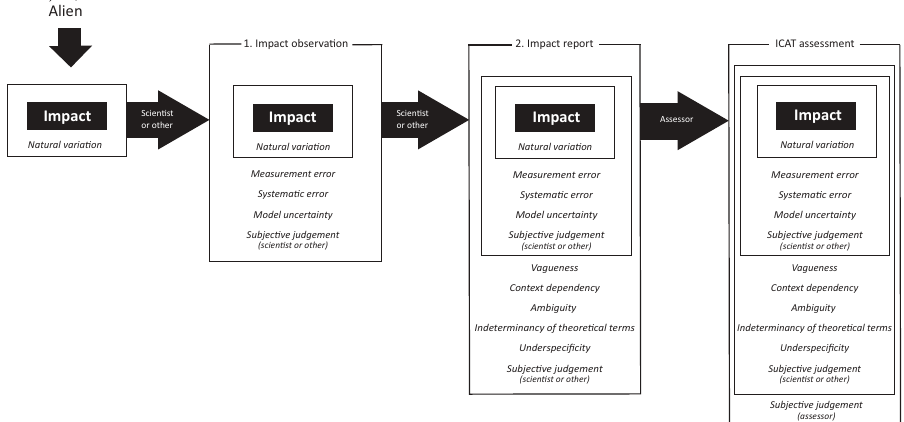
Figure 1. Uncertainties propagate across the process of an impact assessment. The first source of un- certainty emerges due to natural variation associated with the occurrence of an alien species’ impact on native biota. Uncertainties arise at three key stages when information on the impact of an alien species is captured 1) the impact observation stage; i.e. when the impact is measured 2) the impact report stage; i.e. when the impact is communicated in some form of report and finally, 3) at the ICAT assessment stage; i.e. when the assessment is conducted. Any uncertainty that arises will be carried through to the subsequent stages, as illustrated through the encapsulation of uncertainties across the